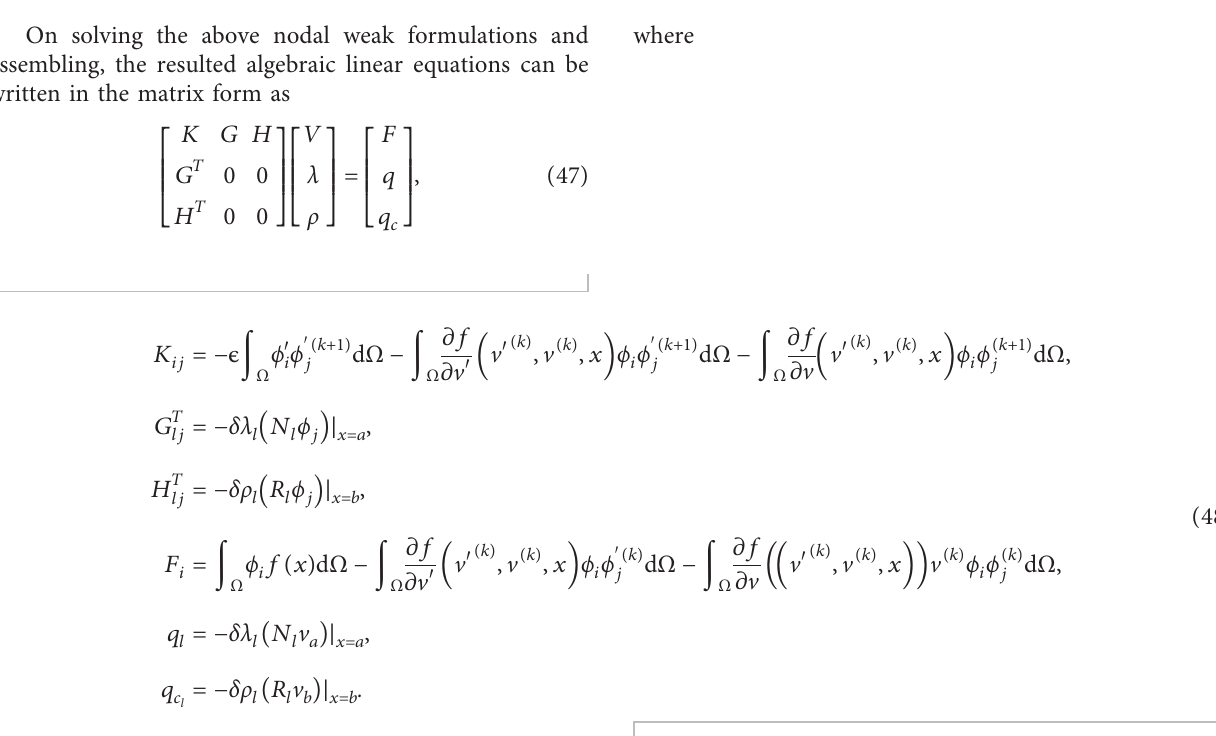
Figure 3: Node distribution for ϵ � 2 − 5 and 2 − 10